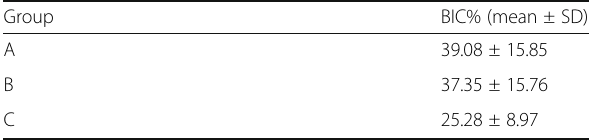
Table 3 Mean BIC% value of each group after 30 days of